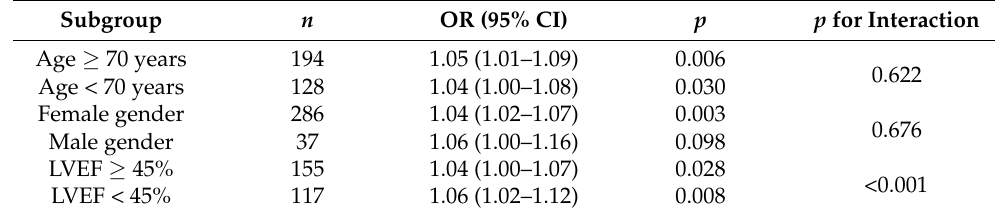
Table A1. Sub-group analysis.